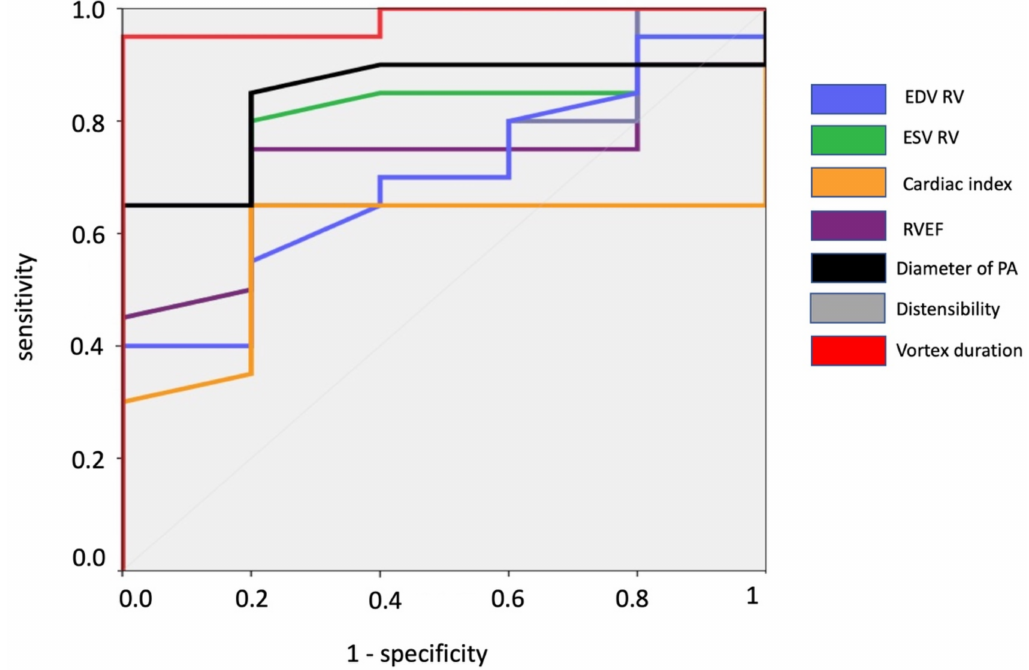
Figure 3. ROC curves analysis to detect PH in patients. The cut-off for definition of PH was 20